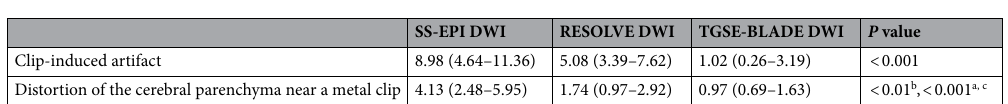
Table 5. Comparison of the length of clip-induced artifact and distortion of the cerebral parenchyma near the metal clip among the three DWIs. Data are presented as the median (interquartile range) (mm). Length of clip-induced artifact was the difference between T2WI and each DWI. a SS-EPI DWI versus RESOLVE DWI; b RESOLVE DWI versus TGSE-BLADE DWI; c SS-EPI DWI versus TGSE-BLADE DWI.